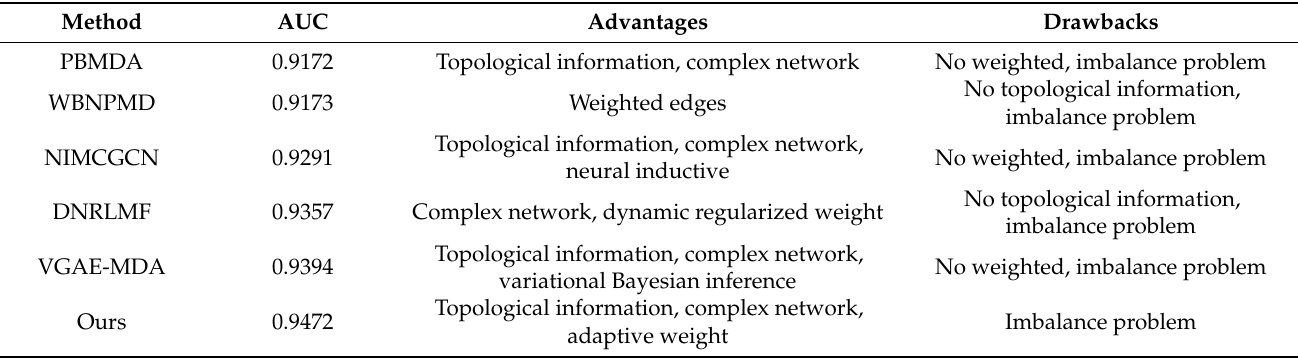
Table 6. The advantages and drawbacks of our method and other